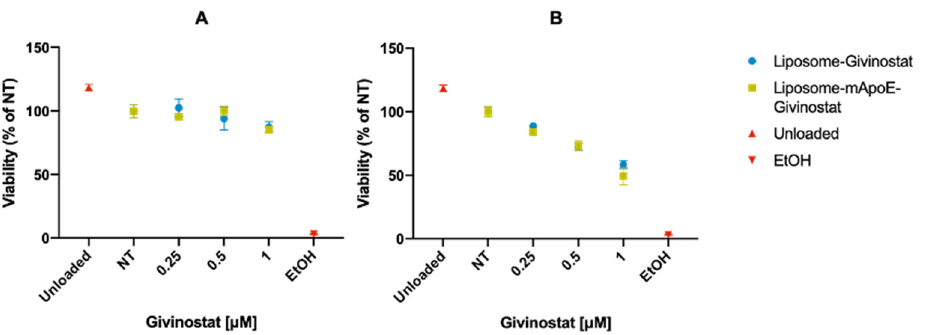
Figure 4. Evaluation of the cytotoxicity on the Gli36 Δ EGFR ‐ 2 cell line treated with LIP ‐ GIV or